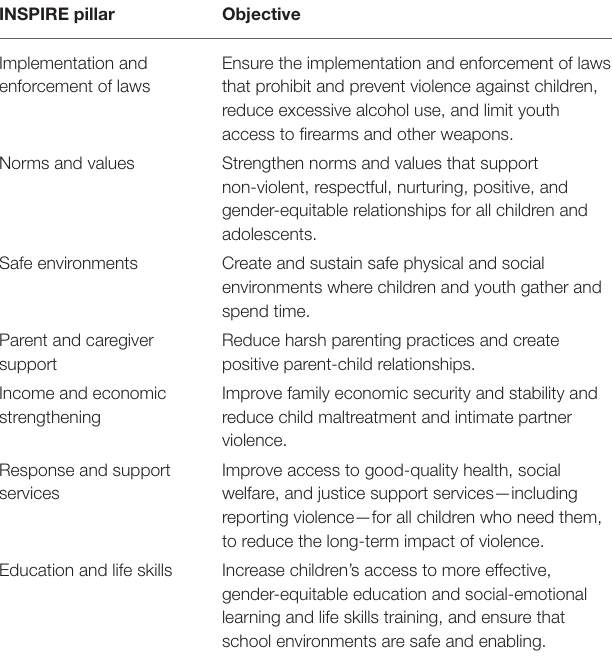
TABLE 2 | The INSPIRE objectives. INSPIRE pillar